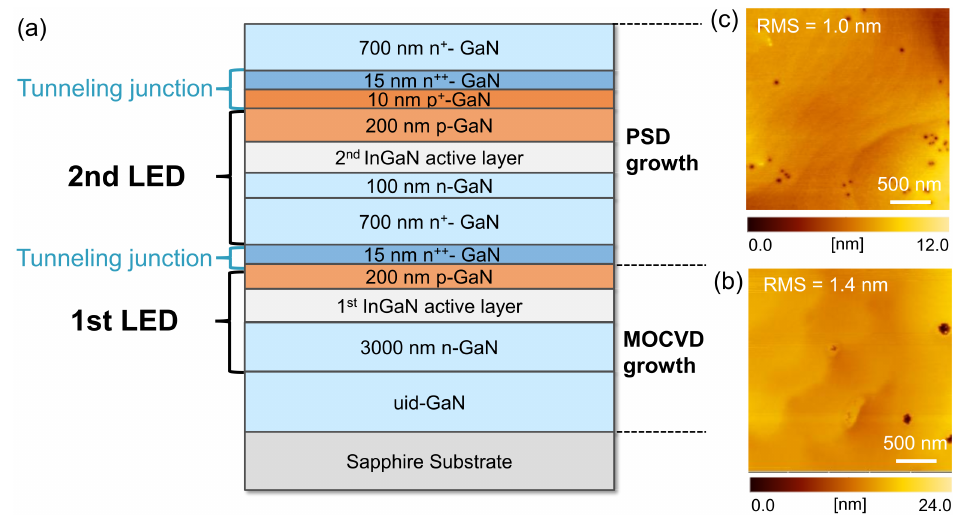
Figure 1. ( a ) A cross-sectional schematic of a tunneling junction connected InGaN LEDs stack with the tunneling junctions. The starting material was an MOCVD-grown LED wafer, and the regrowth interface was located between the 15 nm-thick n ++ -GaN and 200 nm-thick p-type GaN. ( b , c ) AFM images of a starting p-type GaN surface and a top surface of the LED.